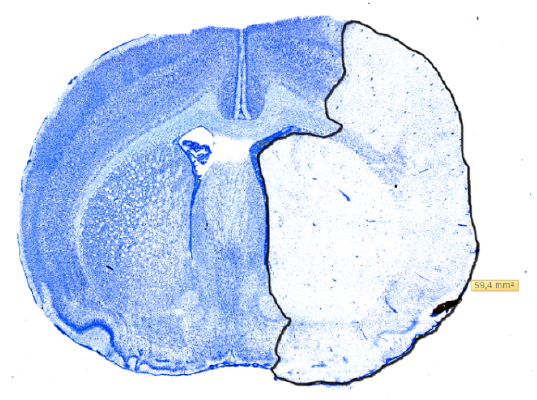
Figure 5. Digitalized coronal section of a rat brain stained with Toluidine-blue showing the measurement of infarcted area using NDP-view 2. The infarction has been outlined in black and the size is reported in mm 2 .